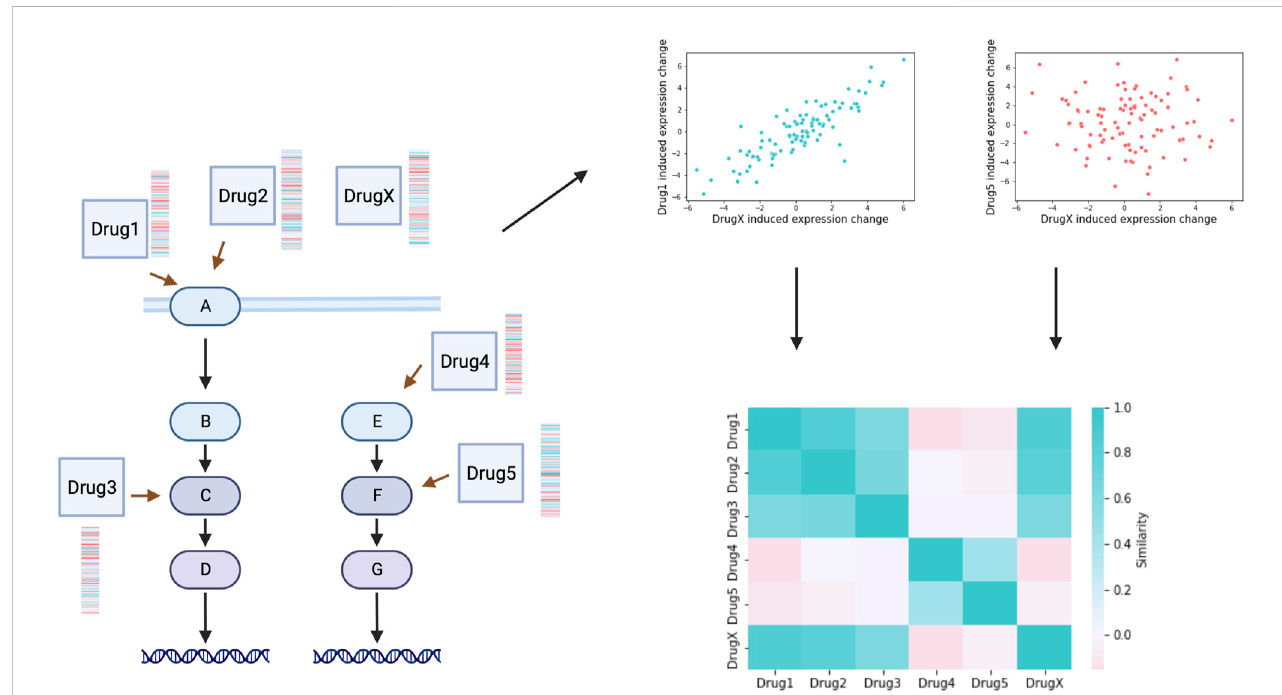
FIGURE 2 Mechanism of action inference. Similarity (correlation or enrichment based) can be calculated between the perturbation gene expression pro fi les of drugswithknownMoA(Drug1-Drug5)andacompoundwithunidenti fi edMoA(DrugX).Similaritymatrixindicatesmechanismofactionrelationshipsofdrugs, and can be used to identify MoA of the unknown compound. Created with